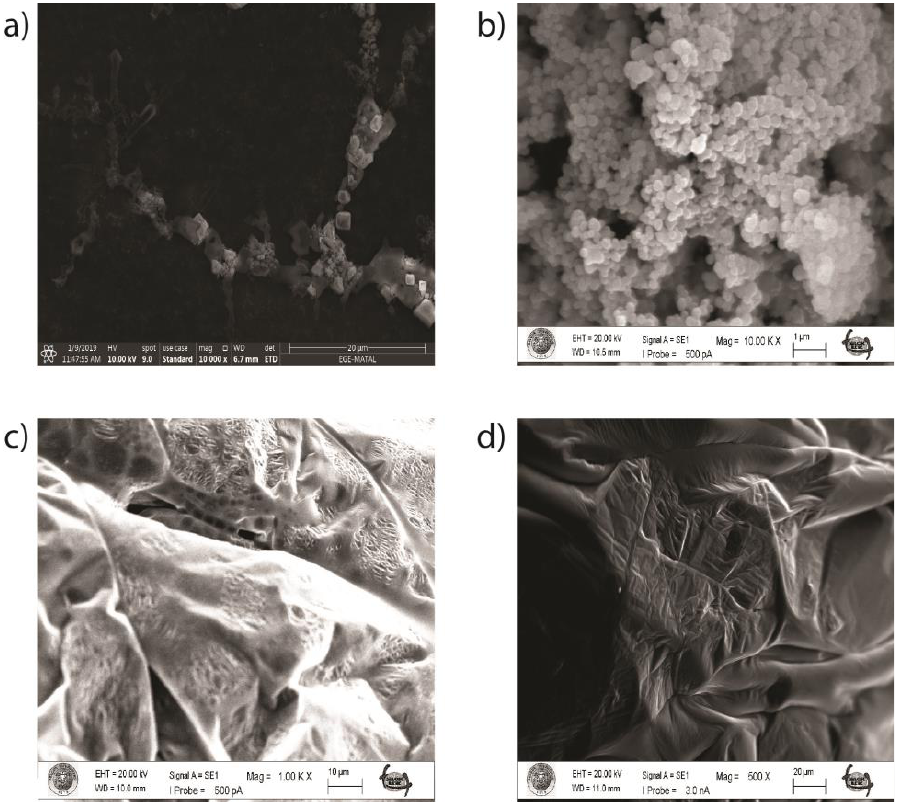
Figure 2. SEM image of obtained nanoparticles and nanoconjugates: ( a ) C-Fe 3 O 4 SEM image, ( b ) C- Fe 3 O 4 -SiO 2 SEM image, ( c ) C-Fe 3 O 4 -SiO 2 -HPG SEM image, and ( d ) DPAPA NC SEM image.